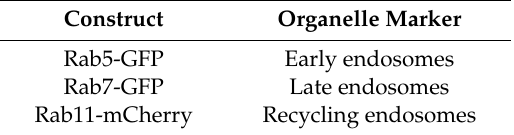
Table 1. Overview of the plasmid constructs used for colocalization